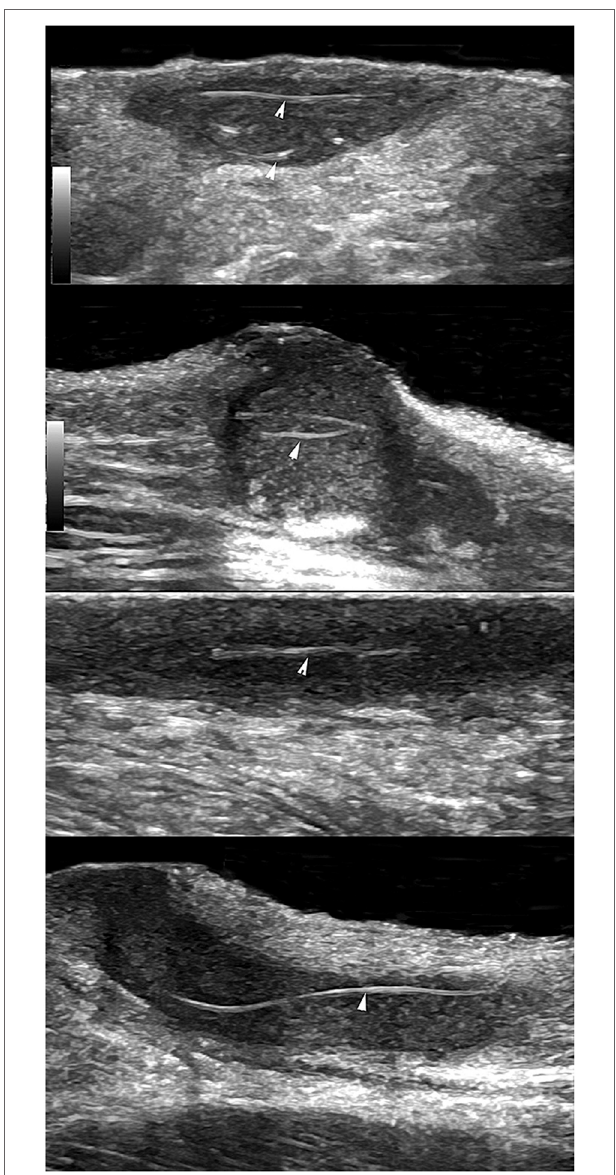
FigURe 2 | Using ultrasound to detect retained hair tracts (indicated by the arrows) within fistulae in hidradenitis suppurativa. This is indicative of regions that could flare with further inflammatory reactions and worsen extent of the disease. The mean length of hair tracts was 4.4 mm with a wide dispersion (SD of 6.9 mm) and a range of 2–31.7 mm. Images were taken with a General Electric Logic E9 with a maximum ultrasound bandwidth of 18 MHz. Permissions obtained to reprint from Wortsman and Wortsman